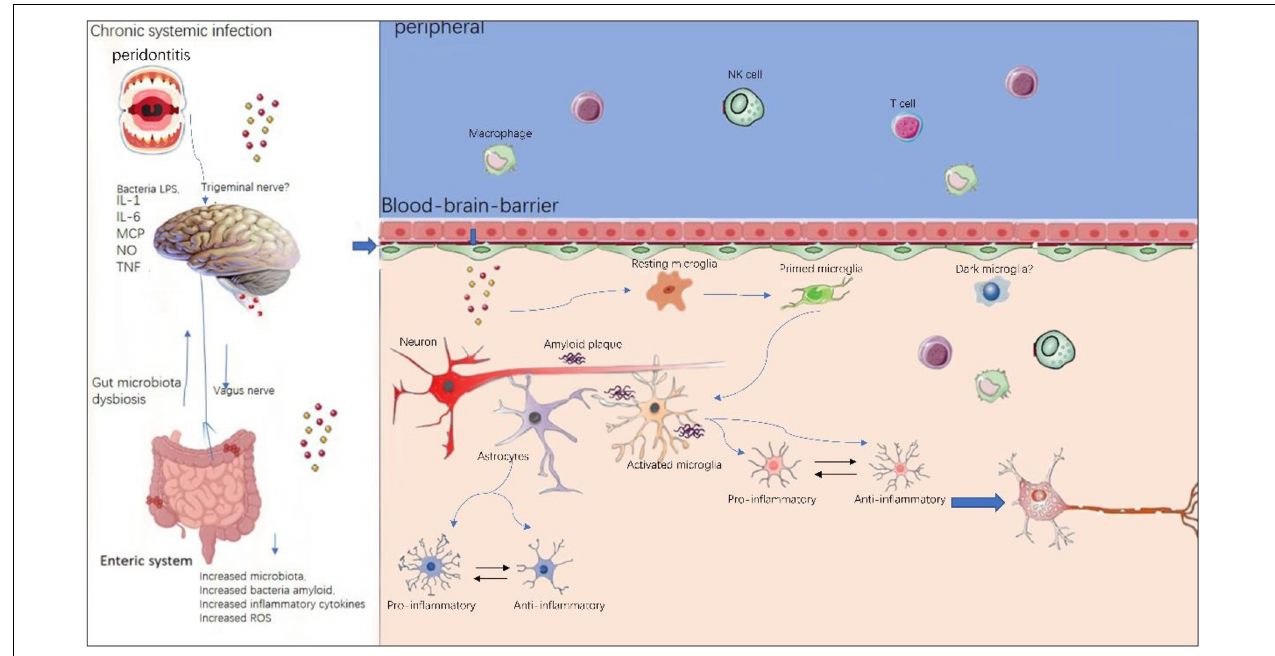
FIGURE 3 | Peripheral and central immune system crosstalk in AD. Chronic systemic infections such as periodontitis and gut microbiota dysbiosis will produce local infection and increased inflammatory cytokines and peripheral immune cells such as peripheral microphages and T cells, NK cells are able to enter the compromised blood–brain-barrier and exacerbate existing neuroinflammation in central nervous system. Within the brain, resident microglia transform from resting state to activated state upon stimulation. Initially, microglia and astrocytes exhibit anti-inflammatory phenotypes, however, sustained chronic inflammation will drive them toward pro- inflammatory phenotypes.